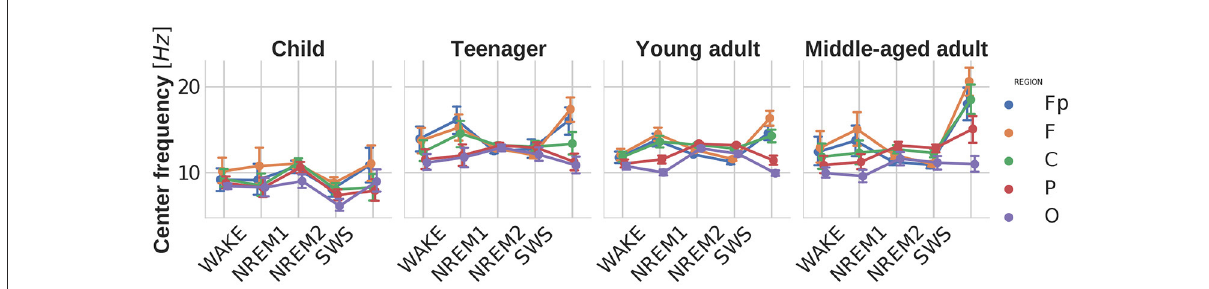
FIGURE4 Central peak frequencies as functions of sleep stage, brain region, and age group. Note the high intersubject variability of central peak frequencies in WAKE, NREM1, and REM stages, as compared to NREM2 and SWS frequencies. This pattern indicates the presence of multiple oscillators with individually variable dominance in WAKE, NREM1, and REM stages, as well as a reliable dominance of sleep spindle waves (11–16 Hz) in NREM2 and SWS. Vertical bars denote 95% confidence intervals.